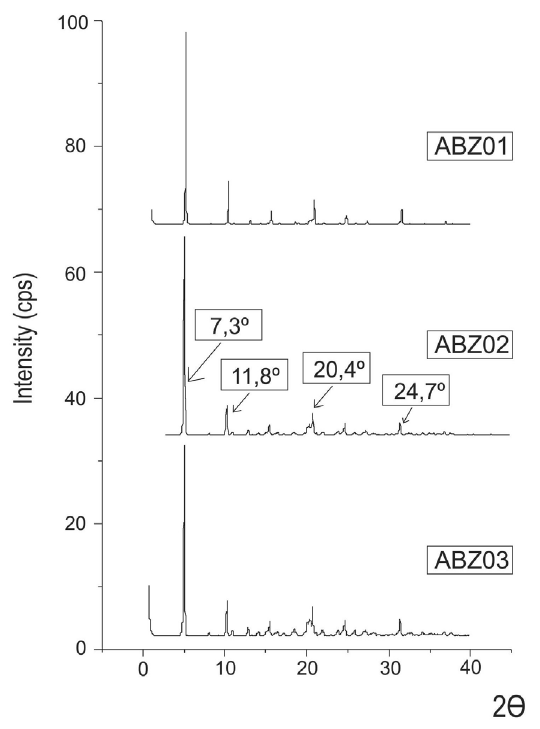
FIGURE 4 - Diffractogram of ABZ01, ABZ02, and ABZ03.